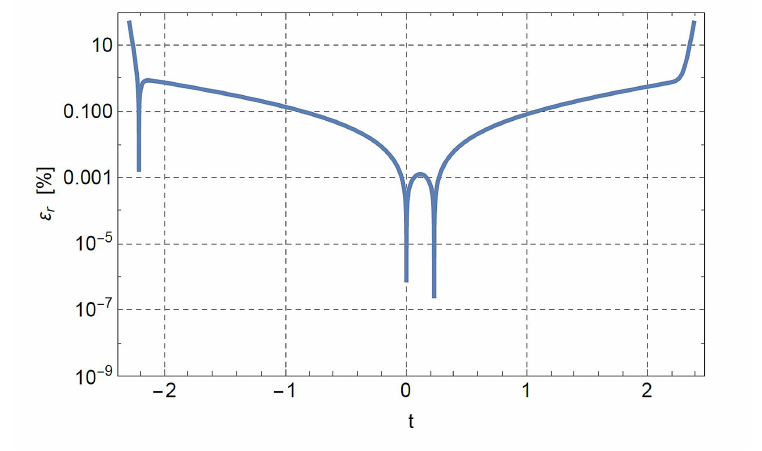
Figure 8. Relative percentage error of the Bell’s approximation of ψ ( t ) in